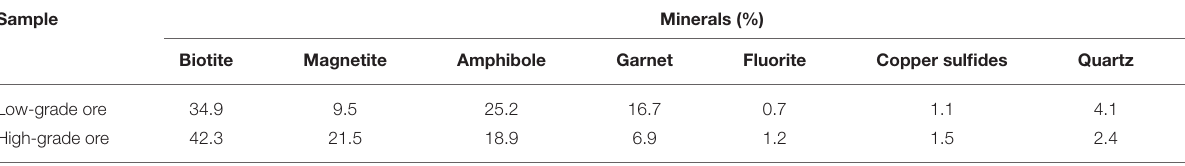
TABLE 2 | Main minerals analyzed in the two ore samples. Sample